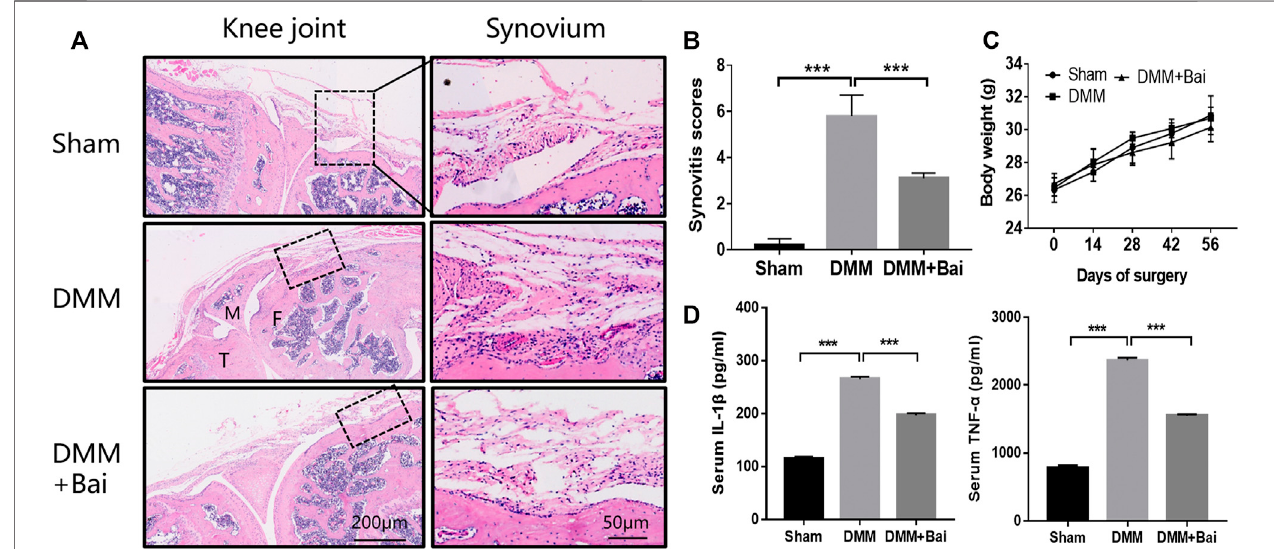
FIGURE 2 | Bai suppresses synovial in fl ammation and serum IL-1 β and TNF- α production in a DMM-induced OA model. (A) Hematoxylin and eosin staining of synovial tissue in each group ( n (cid:1) 5). (B) Synovitis scores in each group at the 8th week postsurgery. (C) The body weight in each group over time ( n (cid:1) 6). (D) IL-1 β and TNF- α levels in serum measured by ELISA. Data are shown as the mean ± SD. *** p < 0.001 vs. the DMM group.